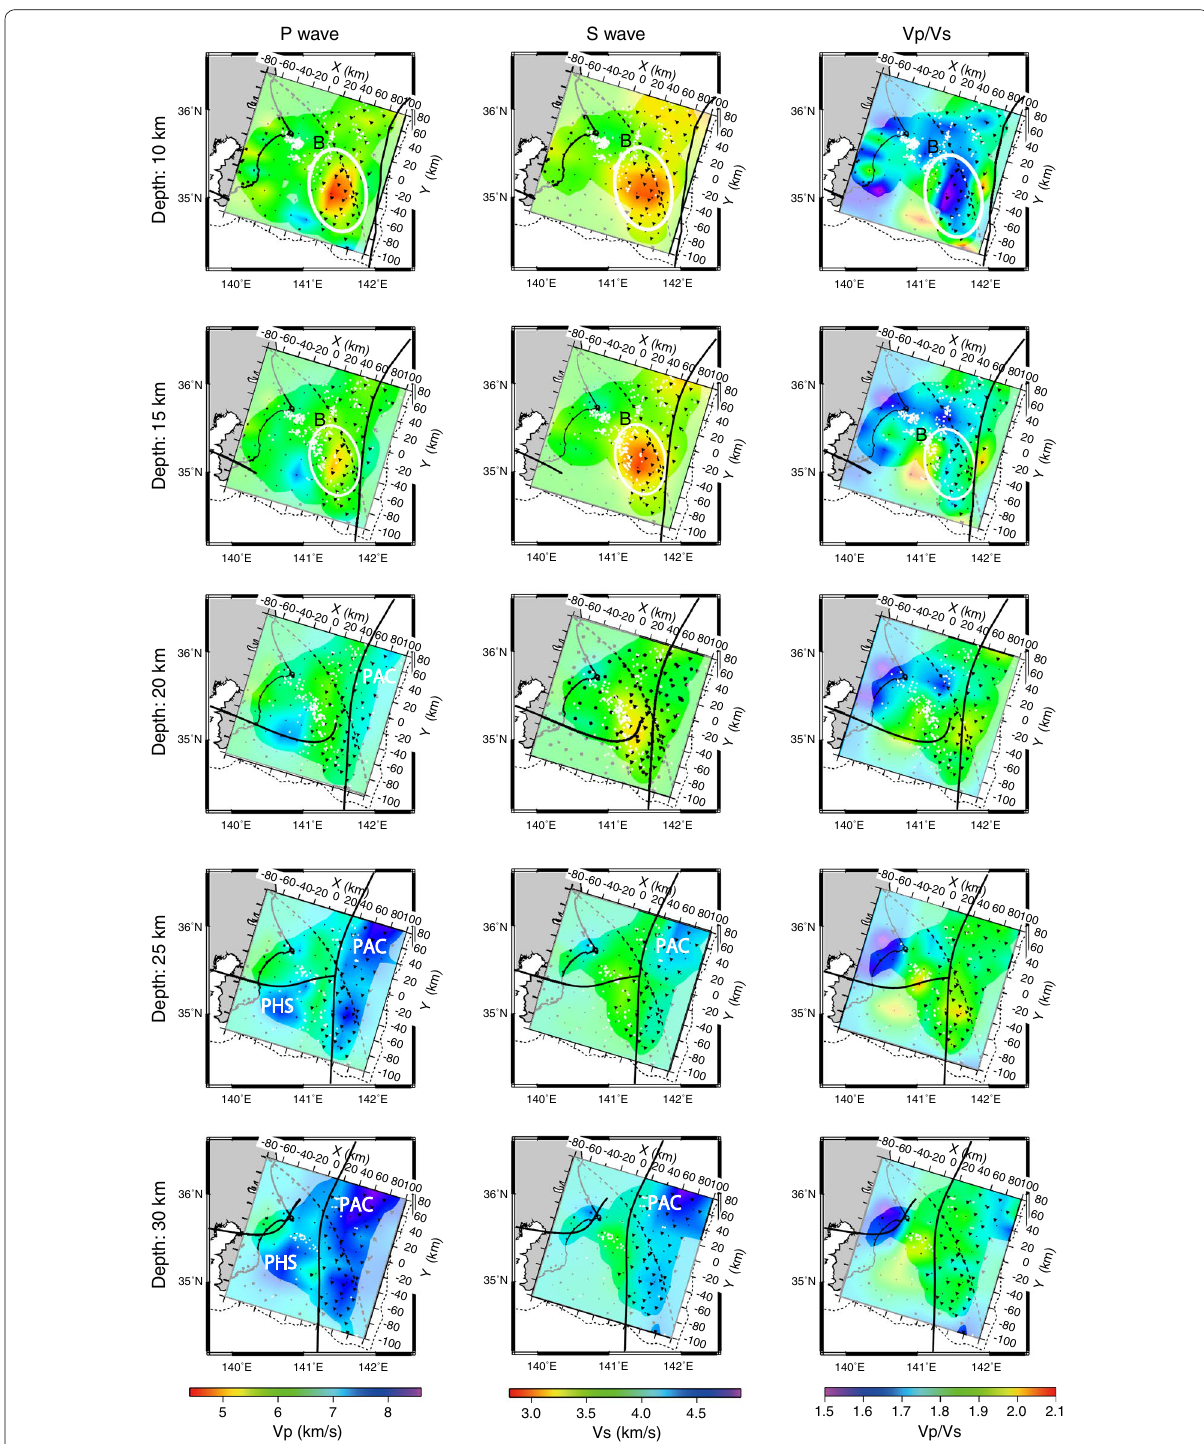
Fig. 3 Results of the tomographic inversion in horizontal section. Velocity structures for P-wave ( left ), S-wave ( middle ), and V p / V s ( right ) are shown. Black triangles and squares indicate stations. White circles indicate earthquakes within 10 km from each section. Black crosses represent the locations of velocity nodes. Black bold lines indicate the location of the upper boundaries of the PAC (Nakajima et al. 2009) and PHS (Uchida et al. 2010) at each depth. The black dashed line denotes the northeastern limit of the PHS (Uchida et al. 2009). High-velocity anomalies associated with the mantle part of the PAC and PHS are indicated by “PAC” and “PHS,” respectively. The low-velocity anomaly in the NA plate is indicated by the white circle labeled